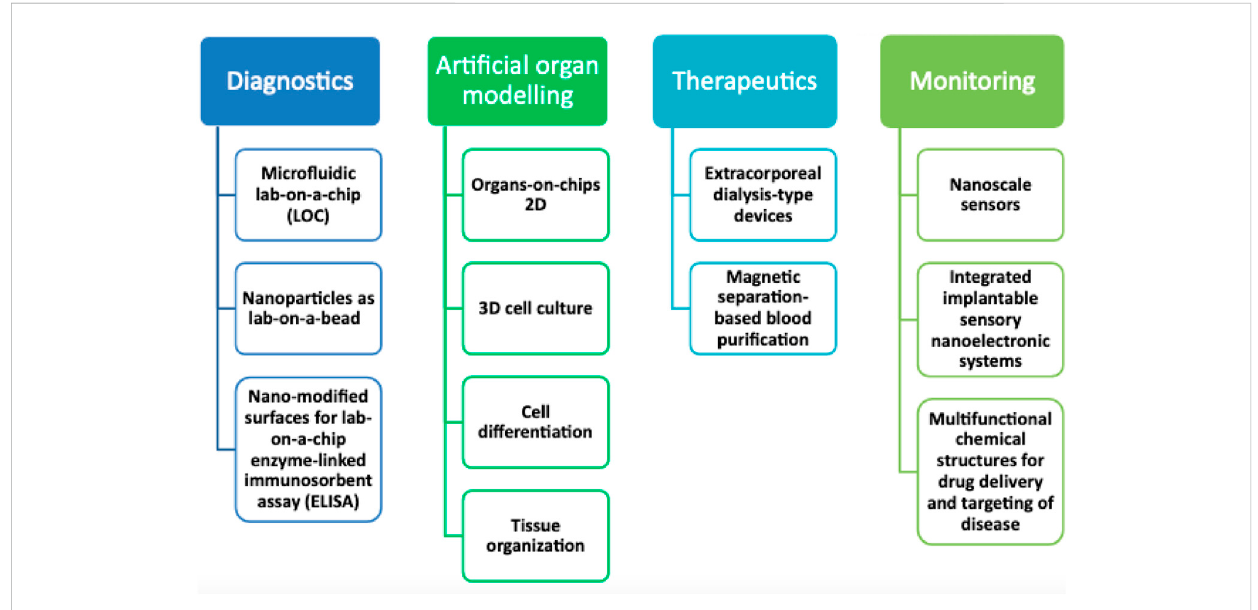
FIGURE 1 Future potential for nanotechnology advancement in critical care medicine study and experimentation in the next